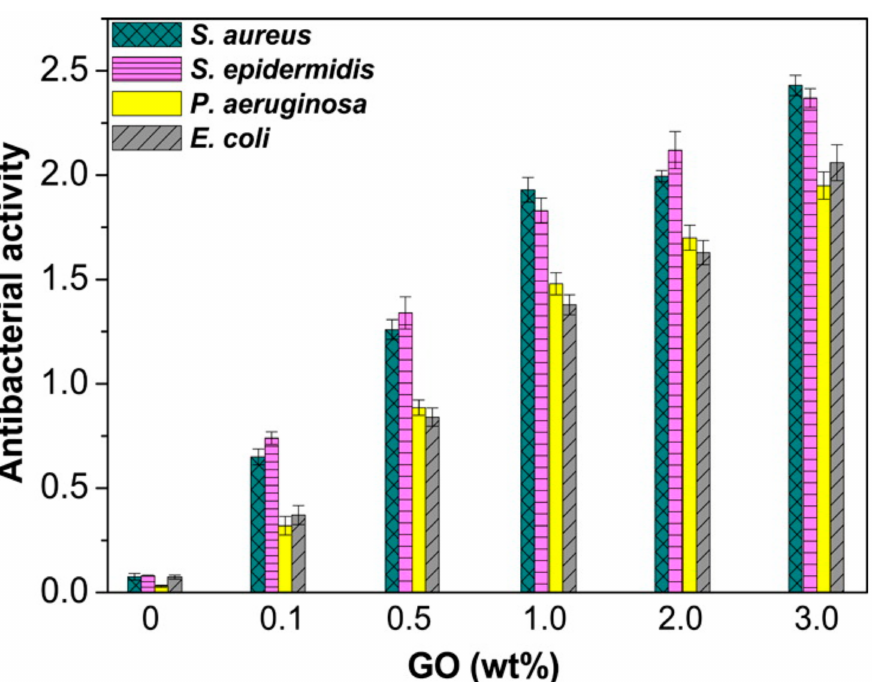
Figure 5. Antibacterial activity of PPF and PPF/PEG-GO composites with GO loadings of 0.1, 0.5, 1, 2, and 3 wt% against S. aureus, S. epidermidis, P. aeruginosa and E. coli . Antibacterial activity was calculated as: log(viable cell count control /viable cell count composite ). Reprinted with permission from ref. [36]. Copyright 2016 American Chemical